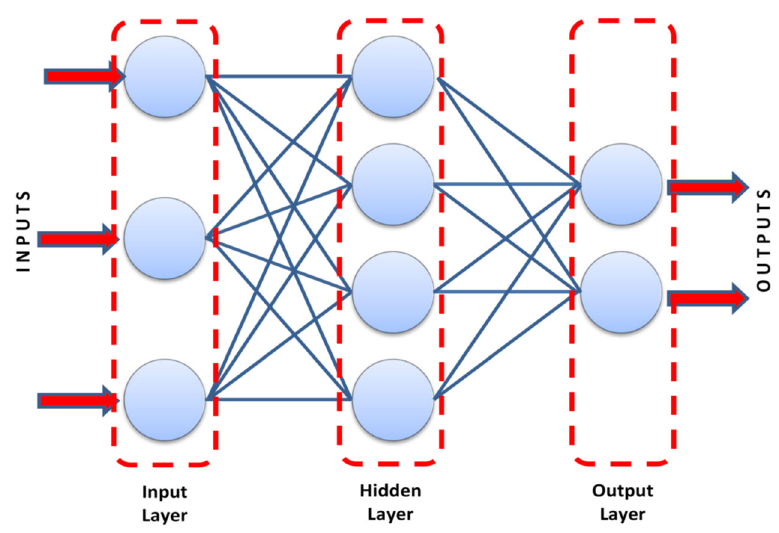
Figure 2. General schematic for the artificial neural network [47], reproduced with permission from Elsevier.